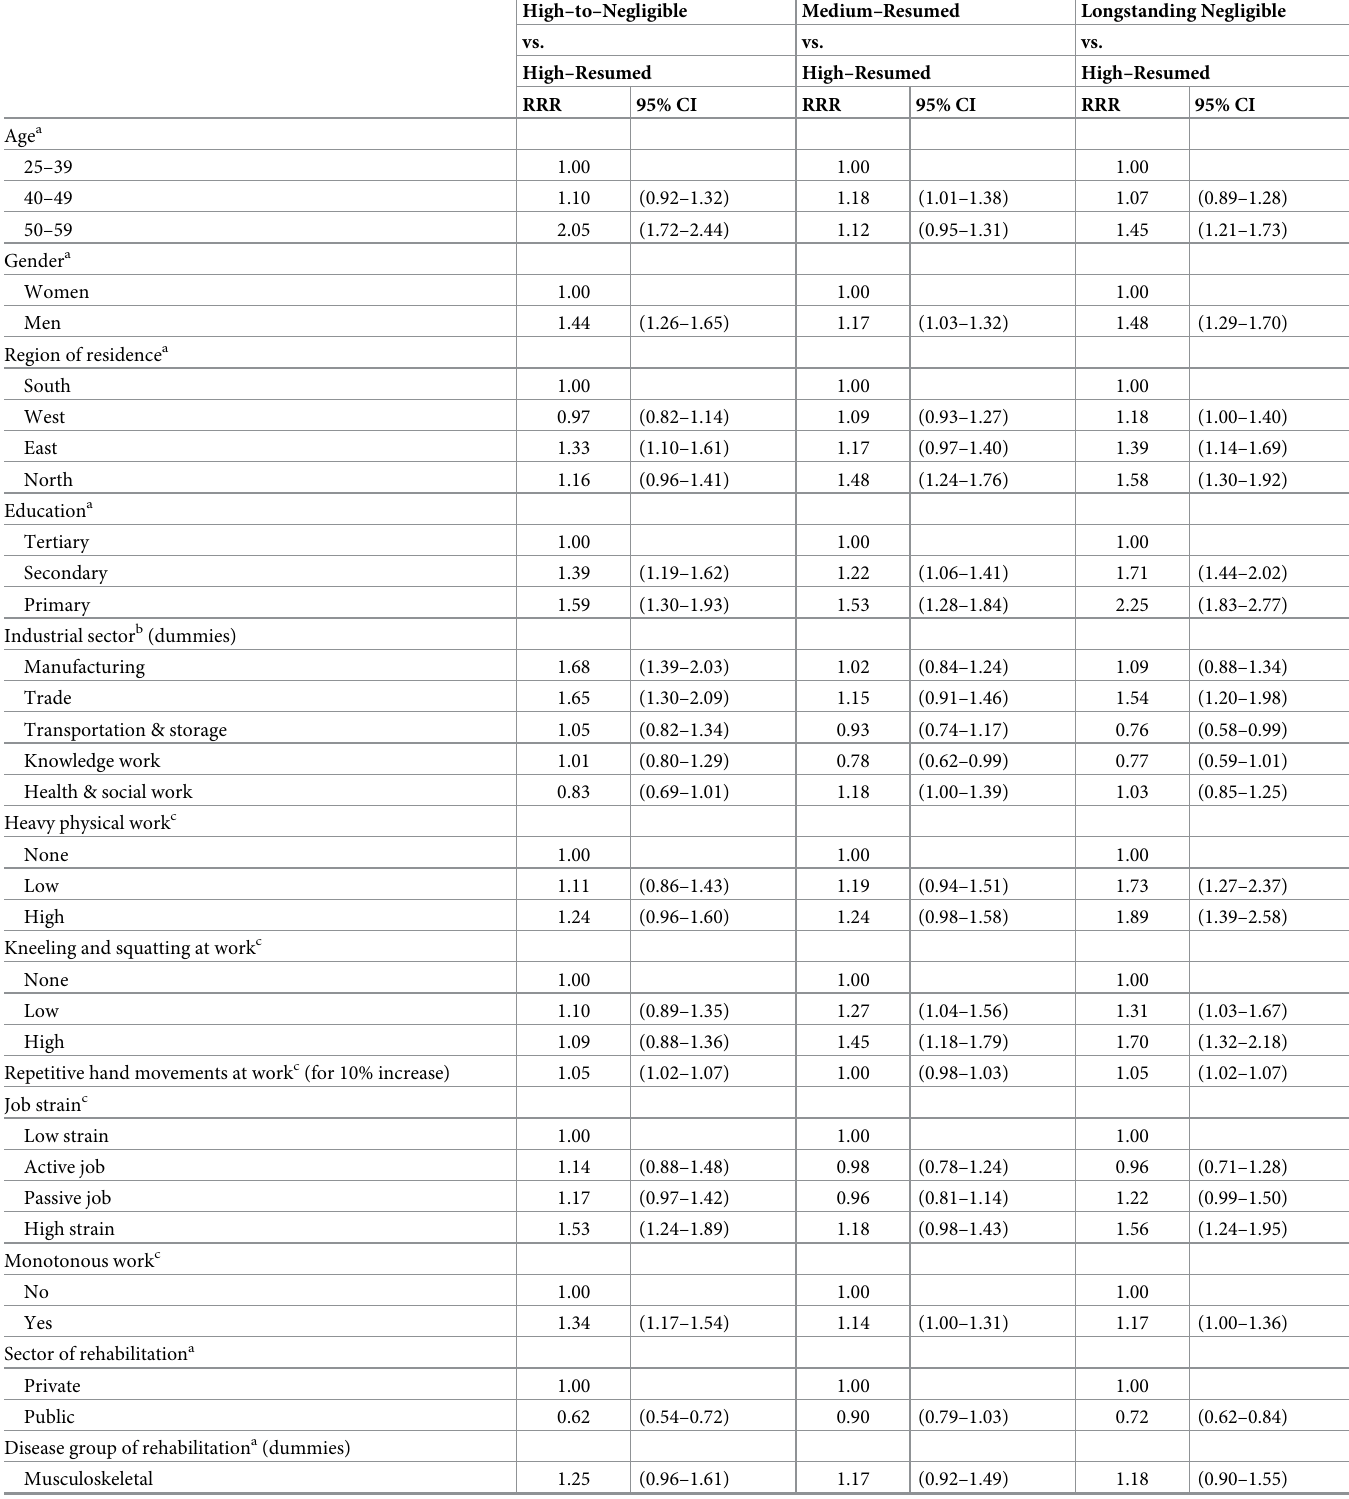
Table 2. Age- and gender-adjusted predictors of being assigned to different trajectory groups of work participation around vocational